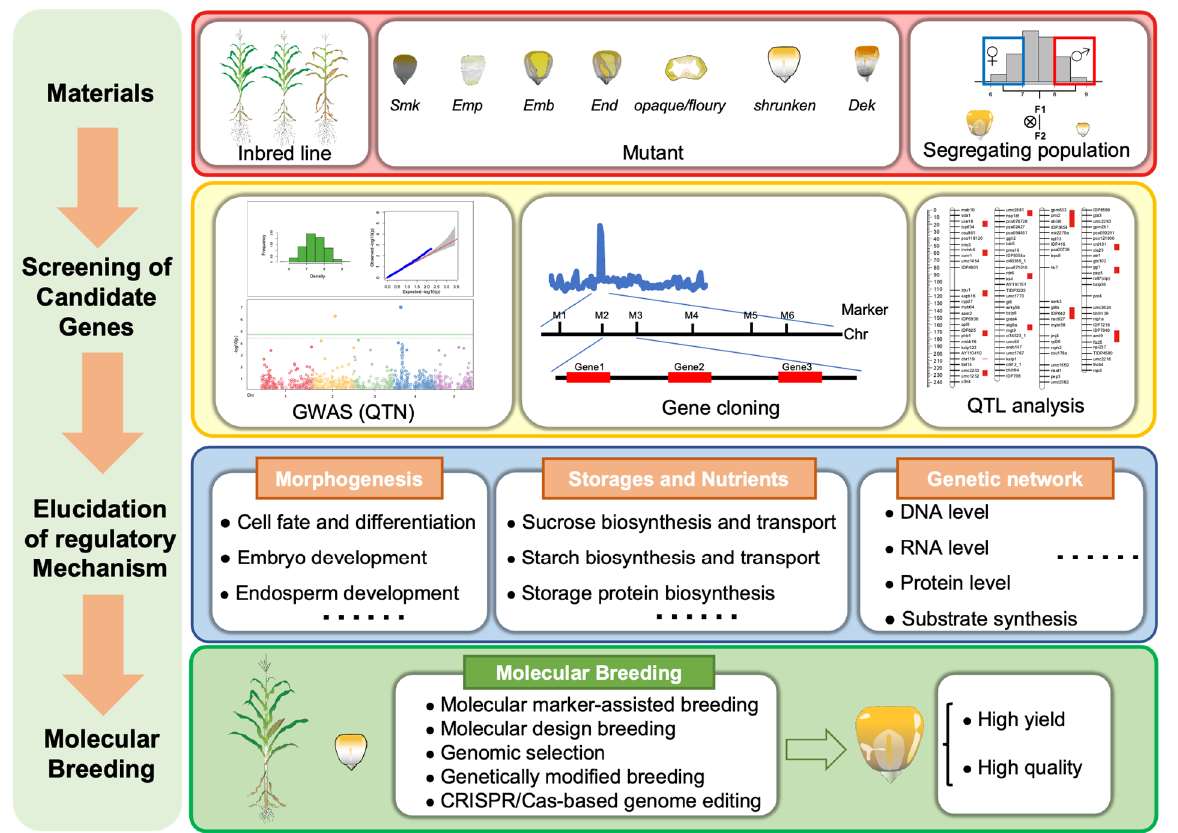
Figure 7. A strategy of how to produce a new generation of high yield and quality maize through molecular breeding. Smk : small kernel mutants; Emp : empty pericarp mutants; Emb : embryo specific mutants; End : endosperm specific mutants; opaque/floury : opaque/floury mutants ; shrunken : shrunken mutants; Dek : defective kernel mutants.